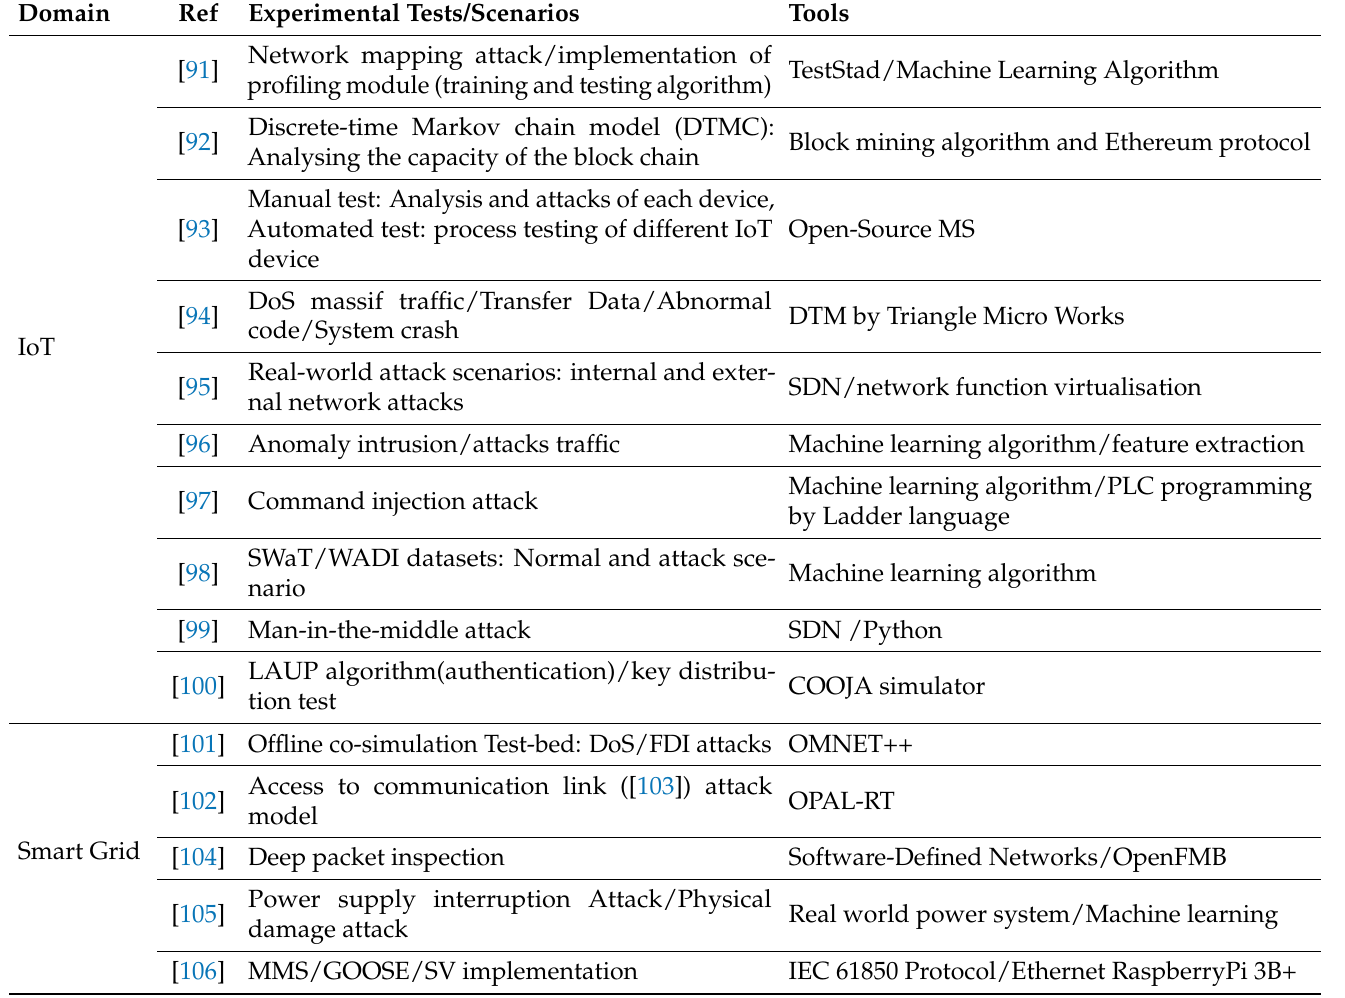
Table 5. A summary of the classes of attacks in next generation aviation